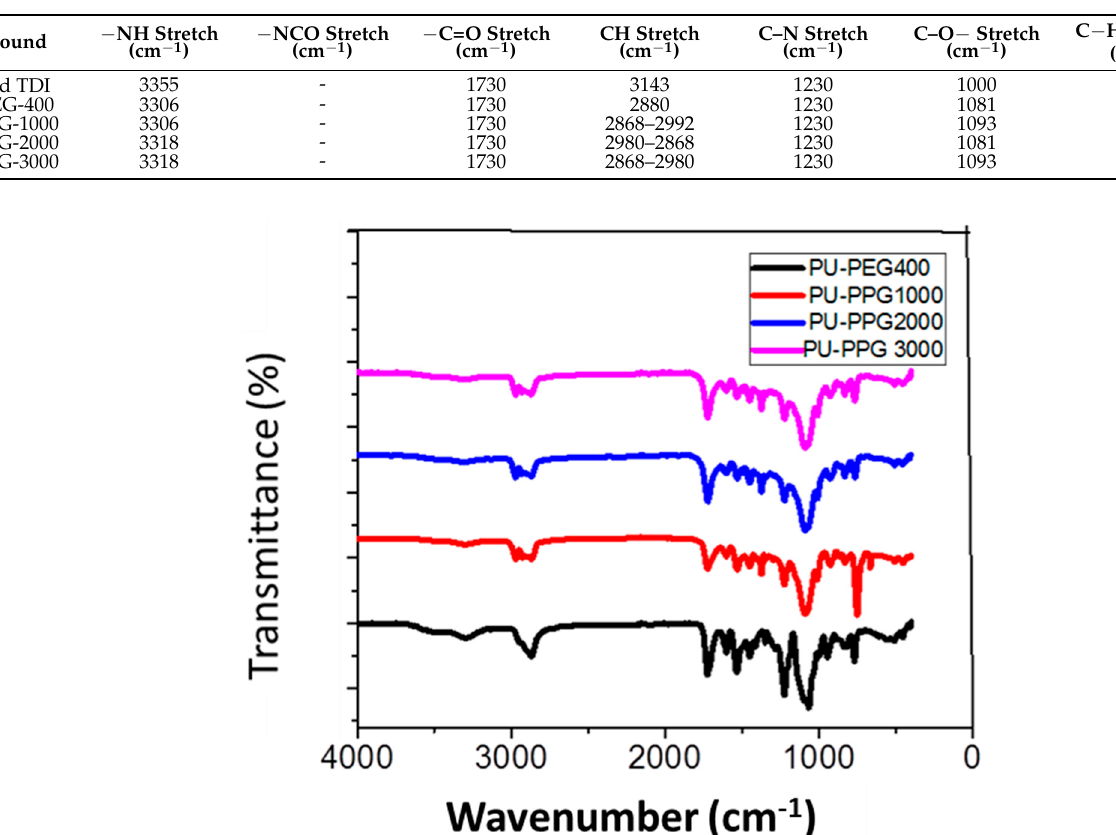
Table 6. FTIR spectral data of blocked TDI and the polyurethane from it.